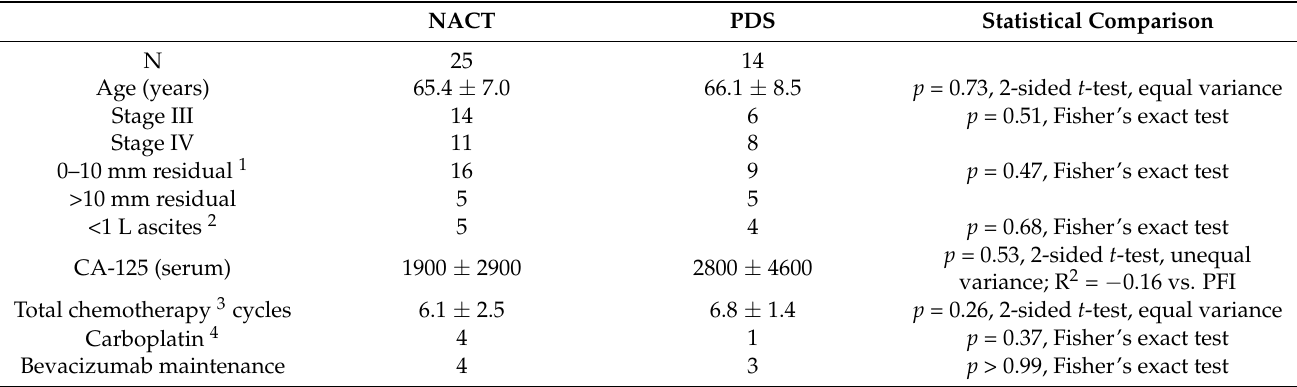
Table 1. Summary of clinical data for NACT and PDS cohorts. NACT PDS Statistical